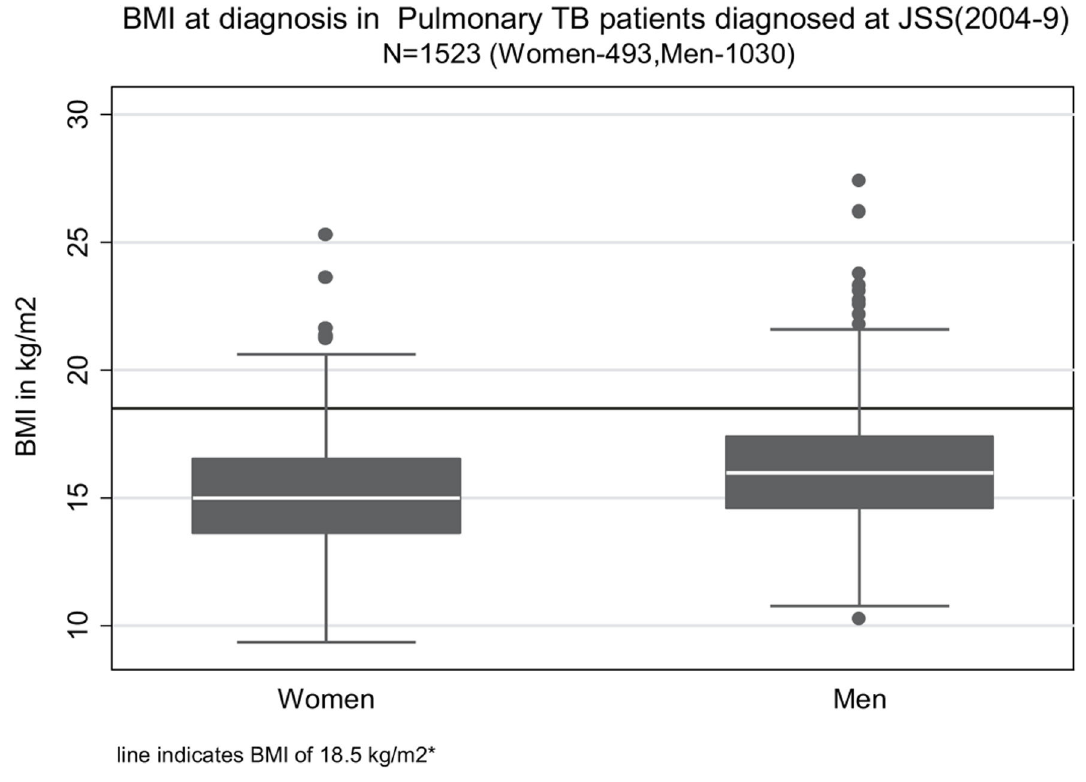
Figure 1. Distribution of body mass index (BMI) at diagnosis in adult patients with pulmonary Tuberculosis at JSS, 2004-9. *BMI of 18.5 kg/m 2 is the cutoff separating under-nutrition (BMI<18.5 kg/m 2 ) from normal range of BMI (18.5-24.99 kg/m 2 ). doi: